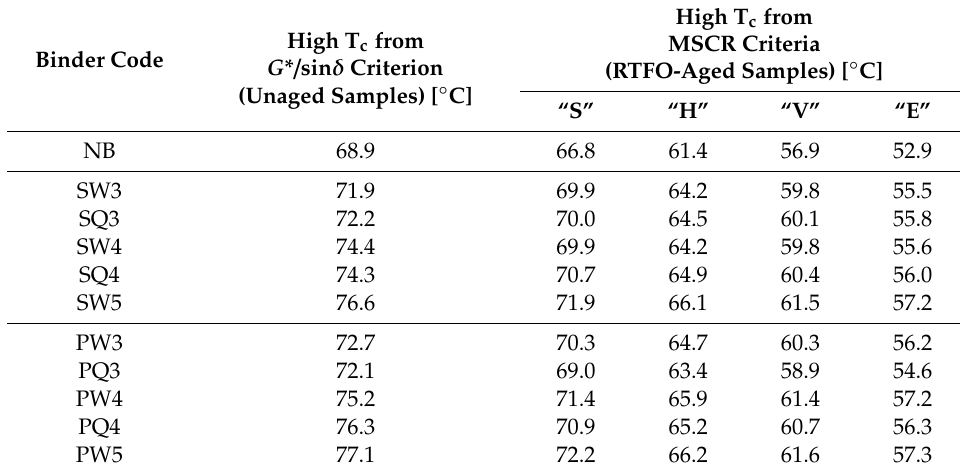
Table 6. High critical